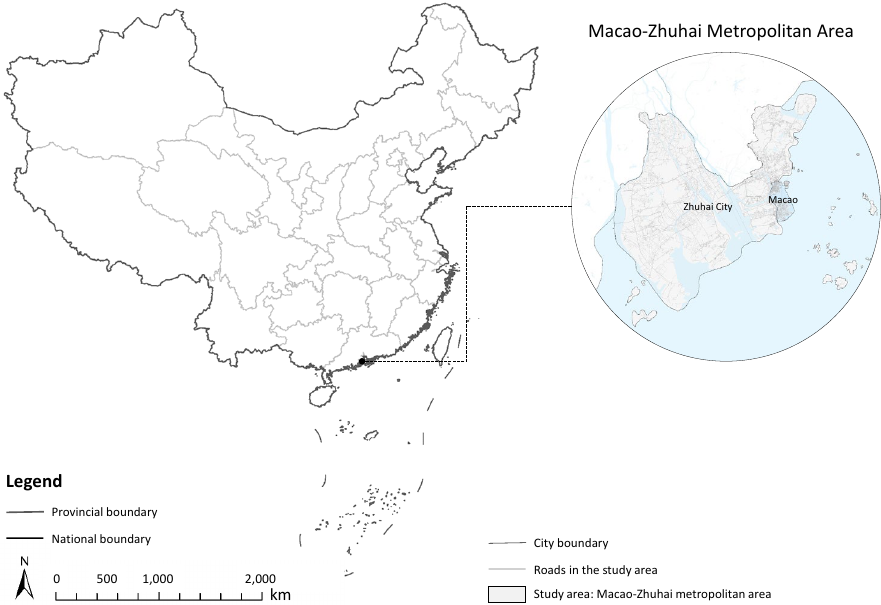
Figure 1. Large-scale maps and the location of the case study site.